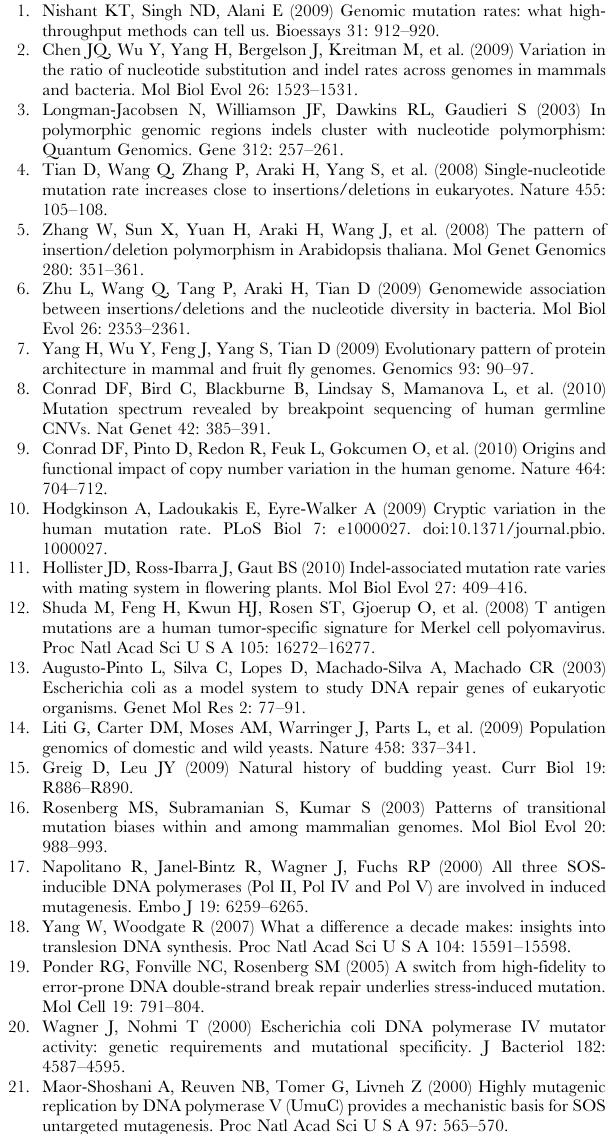
results are plotted in Figure 6. Highlighted in bold are those p values indicating a significant difference between the level of D for categories with a given number of repeats per window when compared to windows with zero repeats, as determined by Wilcoxon Sum Rank test ( p , 0.05).